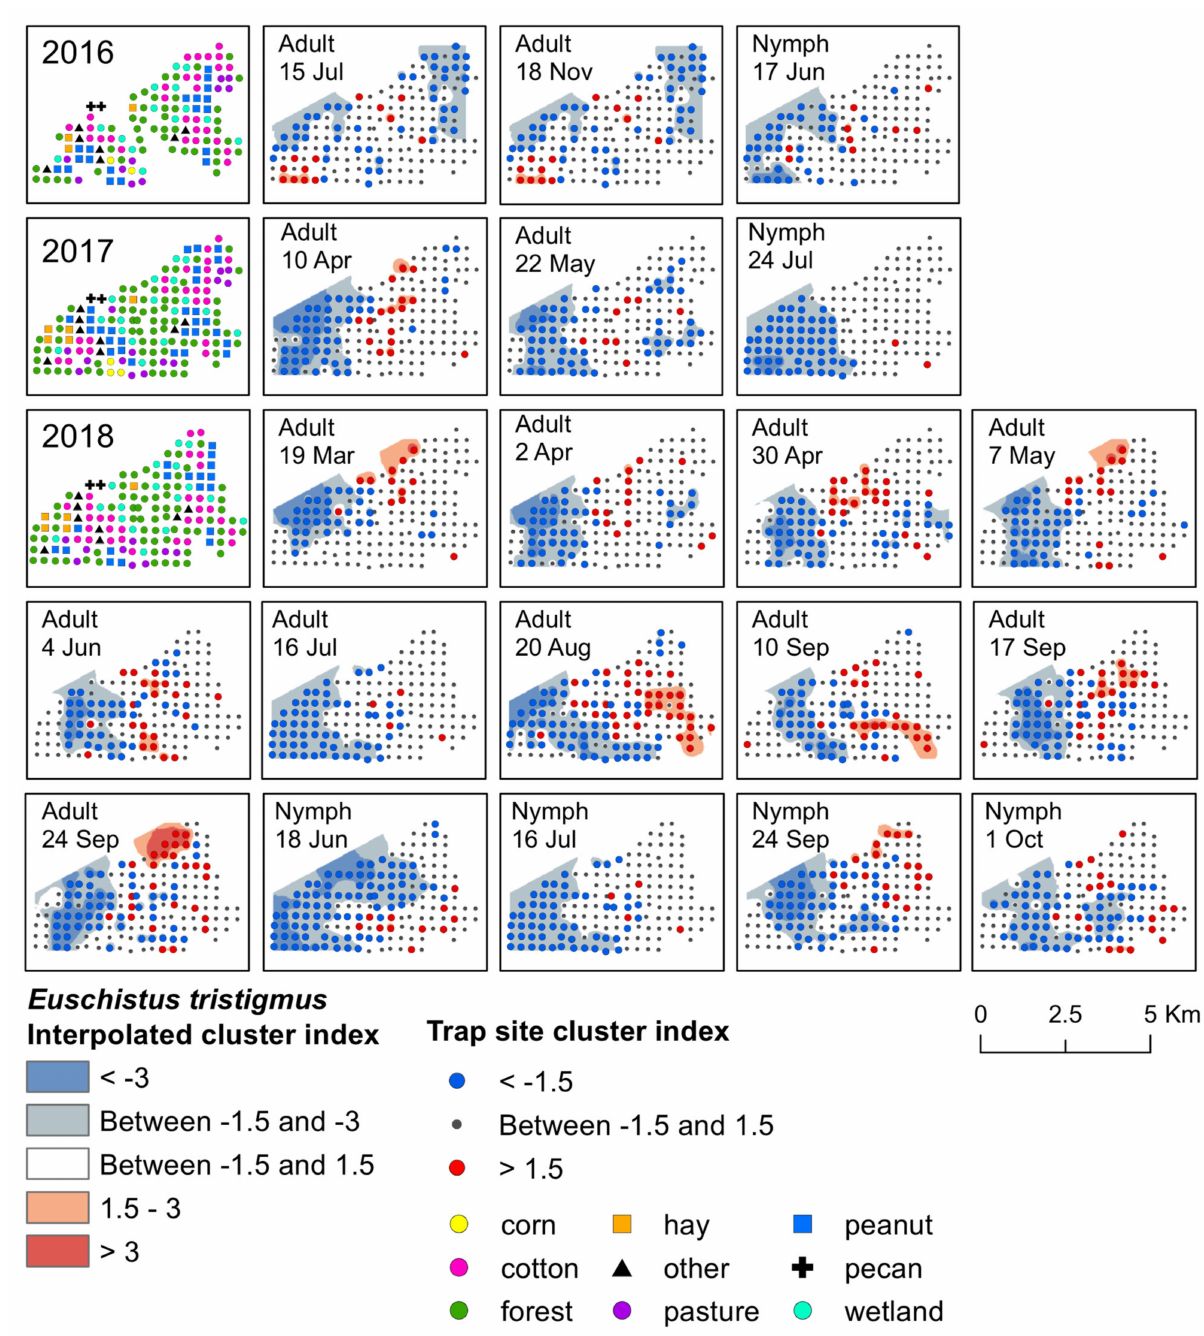
Figure 3. Red − blue plots based on interpolation of the cluster index for E. tristigmus adults and nymphs from 2016–2018. Red areas (>1.5) indicate significant clustering in aggregations in distributions; blue areas (< − 1.5) indicate significant clustering as gaps in